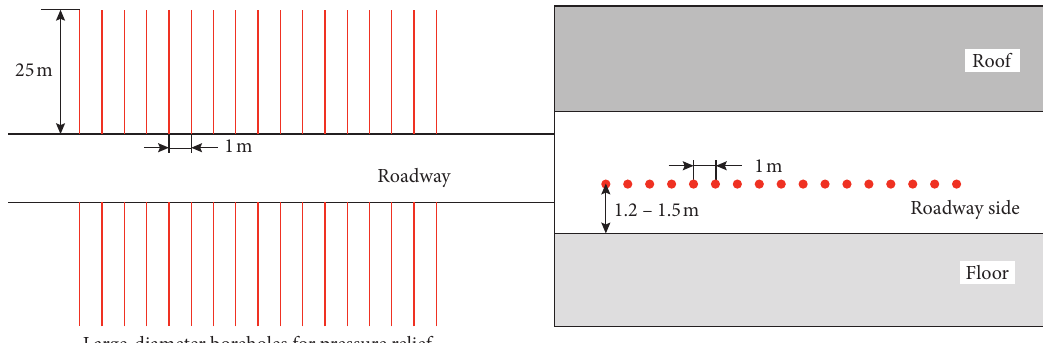
Figure 7: Layout of large-diameter boreholes for pressure